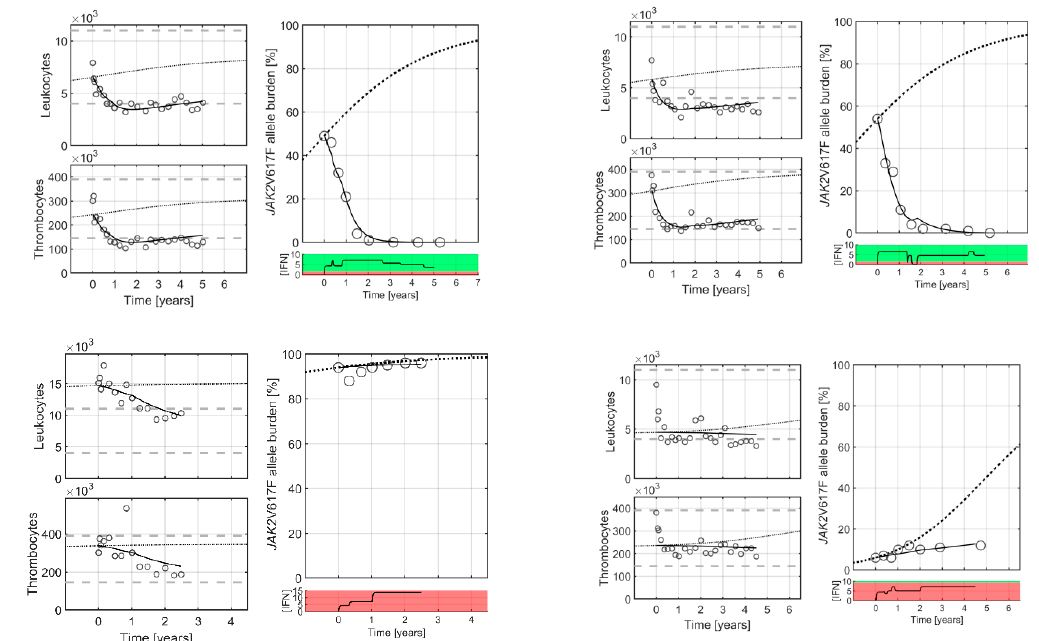
Figure 2. Four typical patients: two good responders ( top row ) and two poor responders ( bottom row ) treated with IFN. Good and poor responders refer to a decrease or increase in allele burden, respectively, regardless of the changes in cell counts. Circles are clinical measurement, whereas full curves are the Cancitis model trajectories. The stipulated curves are sigmoidal increasing “population” master curves based on the data from patients off treatment (see [12]). Death rate of the malignant cells is used to calibrate the Cancitis model to patient-specific data for the JAK2 V617F allele burdens. Measurements of leukocyte and thrombocyte counts are used for validation. Grey horizontal lines indicate the upper and lower limit for the normal cell count ranges, respectively. Below the JAK2 V617F allele burden, figure panels of the patient-specific daily average IFN dose over time are shown. From the Cancitis model, it follows that malignant cells are suppressed and decreasing when the dose is in the green region, and when dose is in the red region the suppression is insufficient. The regions are separated by a patient-specific threshold value. For the JAK2 V617F, leukocyte, and thrombocyte data as well as the model calibration for all patients, see Supplementary Material C.